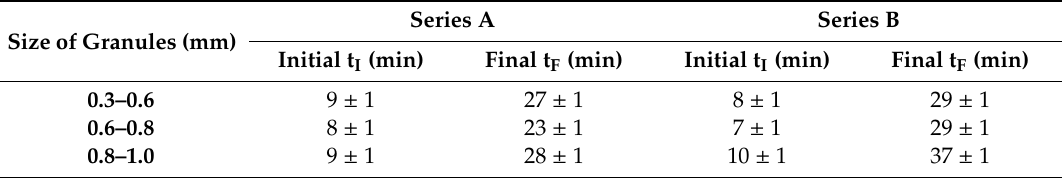
Table 3. The setting times of the biomicroconcretes.